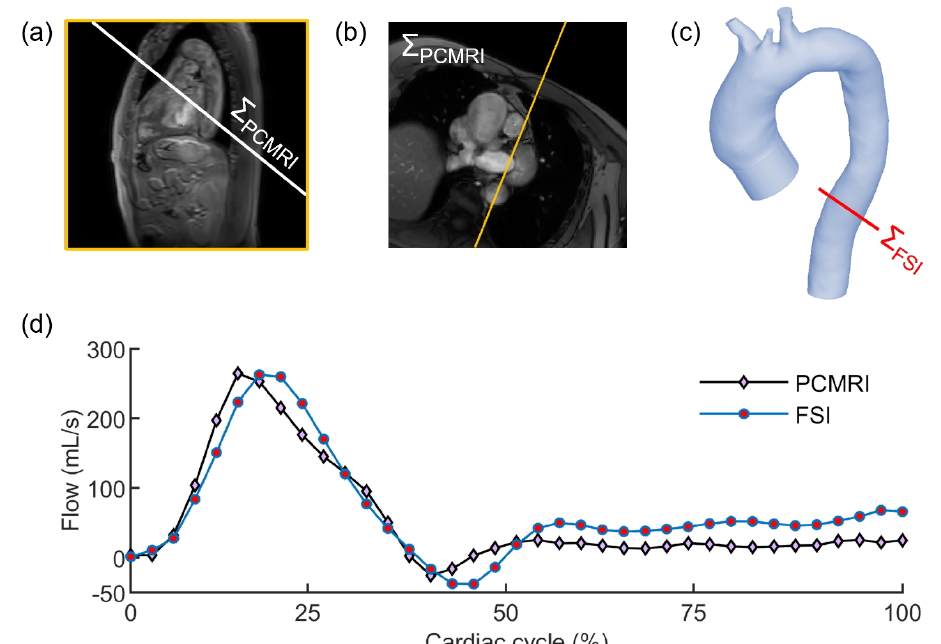
Figure 6. Localizer image ( a ) used to define the acquisition plane Σ PCMRI of the PCMRI at the descending aorta ( b ) and equivalent plane Σ FSI in the FSI domain ( c ); ( d ) comparison between flow curves as extracted from PCMRI data of the patient (black line with diamond markers) and FSI simulation (blue line with circle markers) at the same plane of the descending